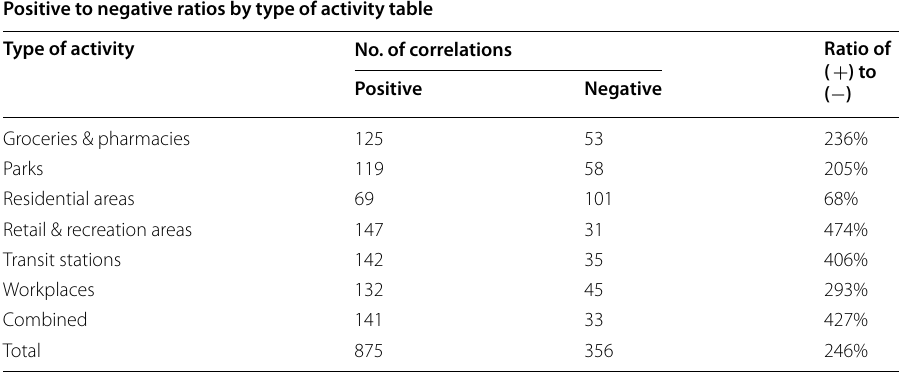
Table 4 Positive to negative ratios by type of activity Positive to negative ratios by type of activity